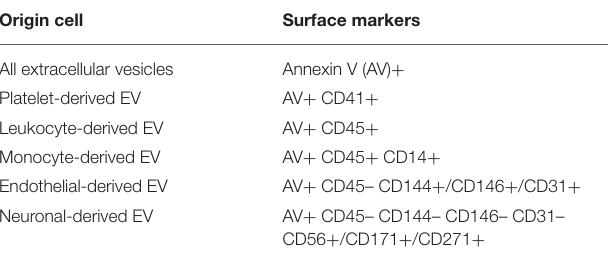
TABLE 1 | Definition of subpopulations of extracellular vesicles based on the surface markers. Origin cell